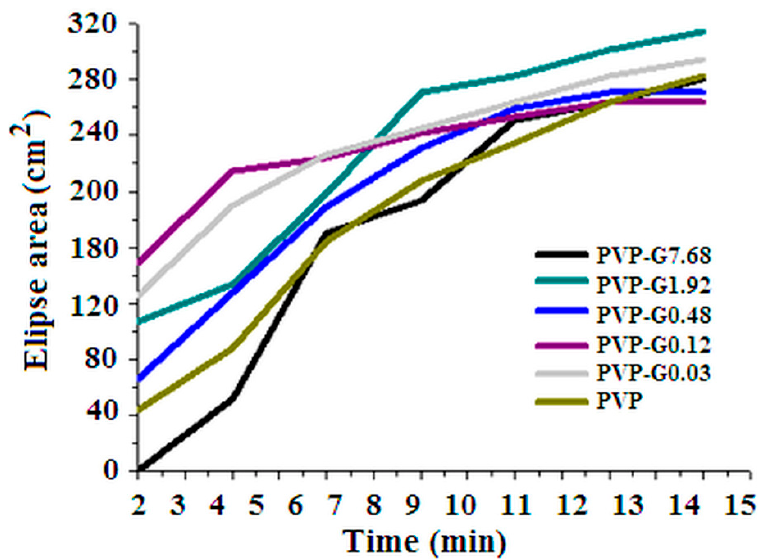
Figure 5. Deposit area as a function of time for samples PVP-G0.03, PVP-G0.12, PVP-G0.48, PVP-G1.92, PVP-G7.68.